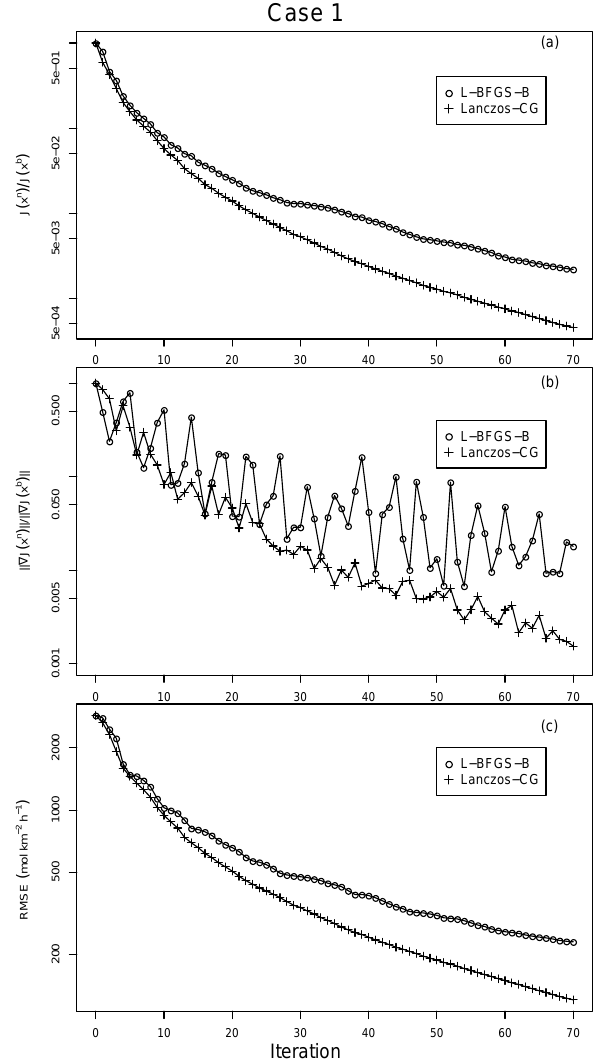
Figure 13. Results of the inverse modeling experiment (Case 1). Panel (a) shows the reduction of the cost function, represented by J( x n )/J( x b ) . Panel (b) shows the reduction of the gradient norm, represented by (cid:107)∇ J( x n ) (cid:107) / (cid:107)∇ J( x b ) (cid:107) . Panel (c) shows the reduc- tion of biospheric CO 2 flux